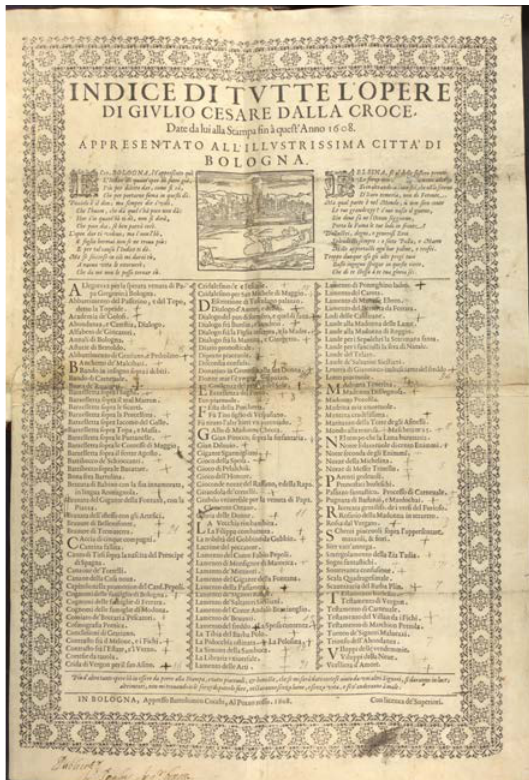
Figure 5 – Indice di tutte l’opere di Giulio Cesare Dalla Croce . In Bologna, appresso Bartolomeo Cocchi, 1608. Biblioteca Universitaria di Bologna, MS 3878, c.[51]. Courtesy of Alma Mater Studiorum – Università di Bologna, Biblioteca Universitaria di